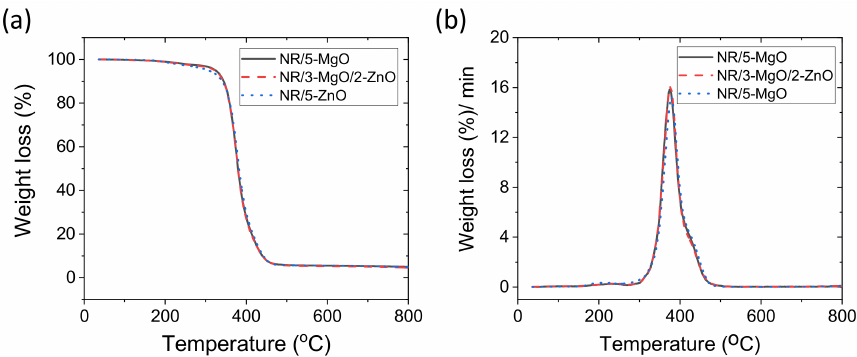
Figure 9. ( a ) TGA and ( b ) DTA results of vulcanized